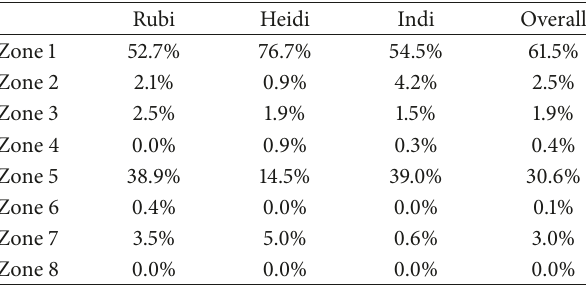
Table 6: Enclosure use values for each female and overall